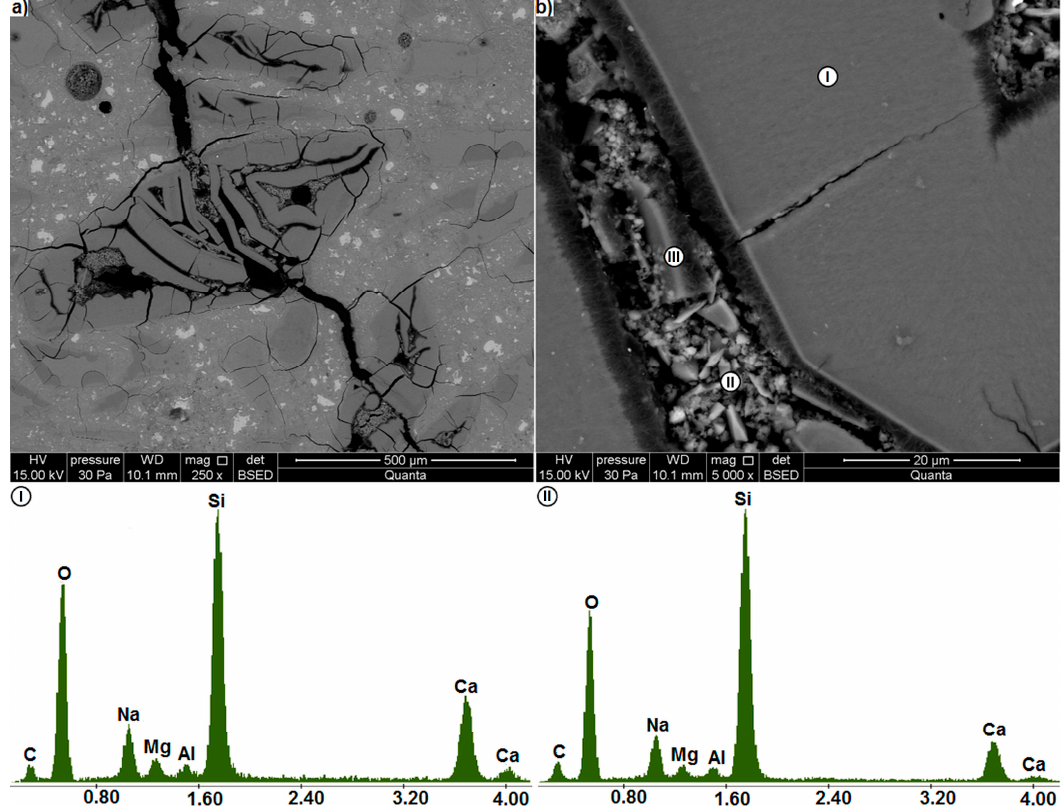
Figure 8. ( a ) Degraded mortar containing cracked waste glass particles, ( b ) a crack in the glass (BSE); EDS analysis at points I and